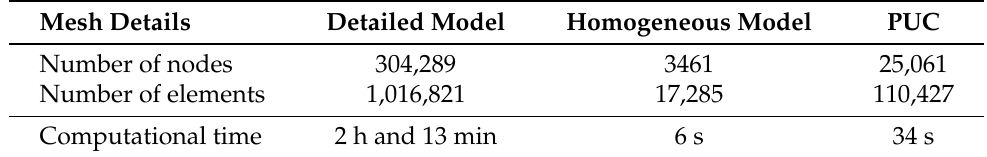
Figure 14. ( a ) Detailed FE model of 1/8 of DT-2 specimen, ( b ) measured loading curves ( x —cross-head displacement), ( c ) solid part of DT-2 PUC (recall Figure 2b), ( d ) PUC finite element mesh, ( e ) coarse FE model of homogenized specimen. Table 6. Details of finite element